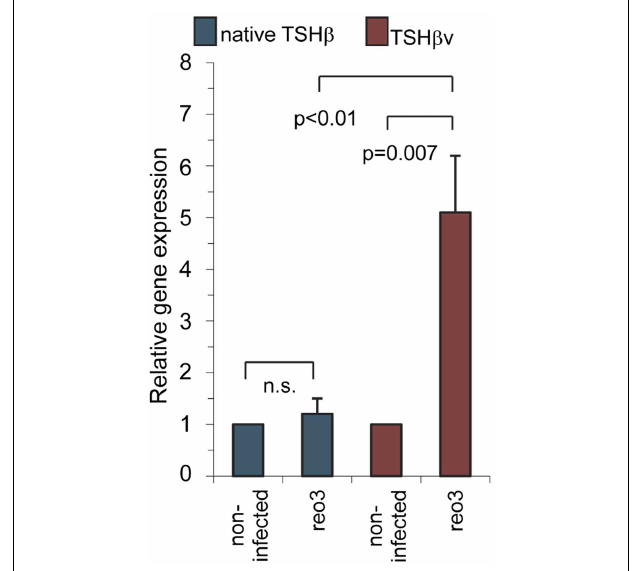
FIGURE 5 | Systemic reovirus infection induces gene expression of TSH β v but not nativeTSH β in thyroid tissues . Mice were infected intraperitoneally with 10 7.5 plaque-forming units of reovirus serotype 3 Dearing strain.Tissues were assayed for gene expression 48h post-infection. Presented data were derived from Ref.